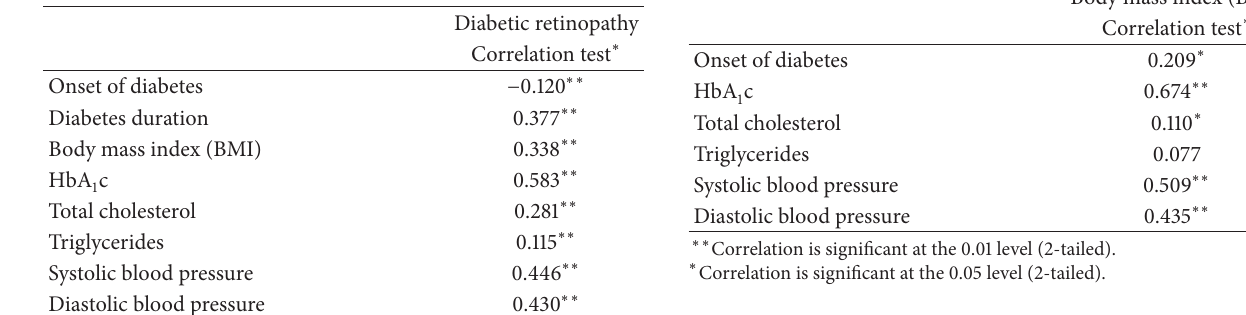
Table 4: Correlation between diabetic retinopathy and diabetes duration, body mass index, metabolic, and clinical parameters in type 2 diabetic patients ( 𝑛 = 545 ).